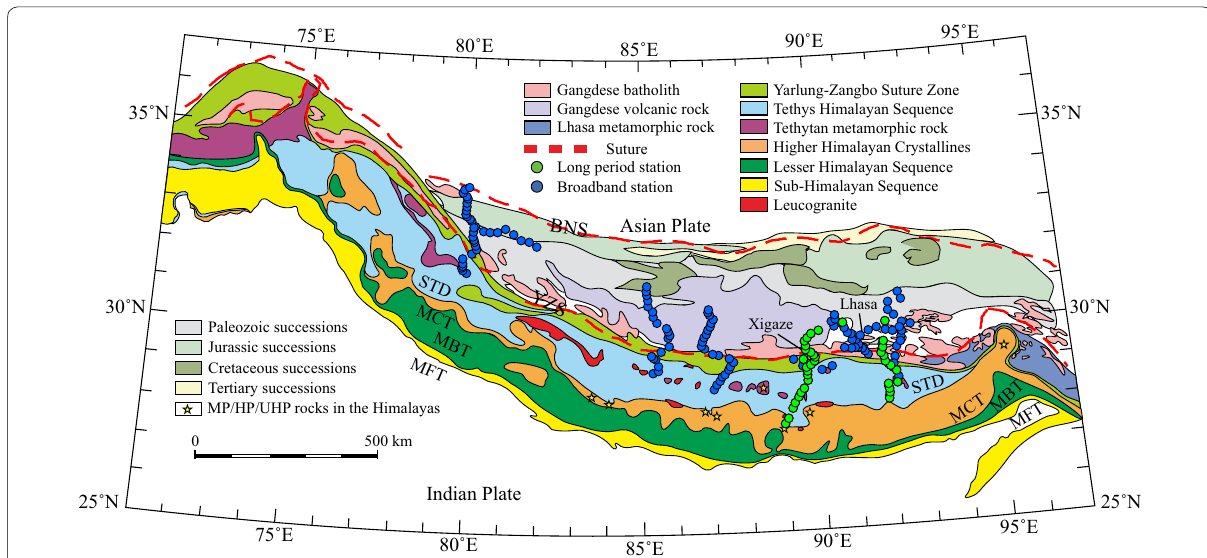
Fig. 2 Simplified geologic map of the study area (modified after Ding et al. 2016a; Hu et al. 2016; Yin and Harrison 2000). The blue circles indicate the broadband data while green ones show the long period data. The dashed red lines show the sutures, YZS and BNS. South Tibetan detachment (STD), Main Central Thrust (MCT), Main Boundary Thrust (MBT), Main Frontal Thrust (MFT), Medium-pressure (MP), High-pressure (HP), and Ultrahigh- pressure